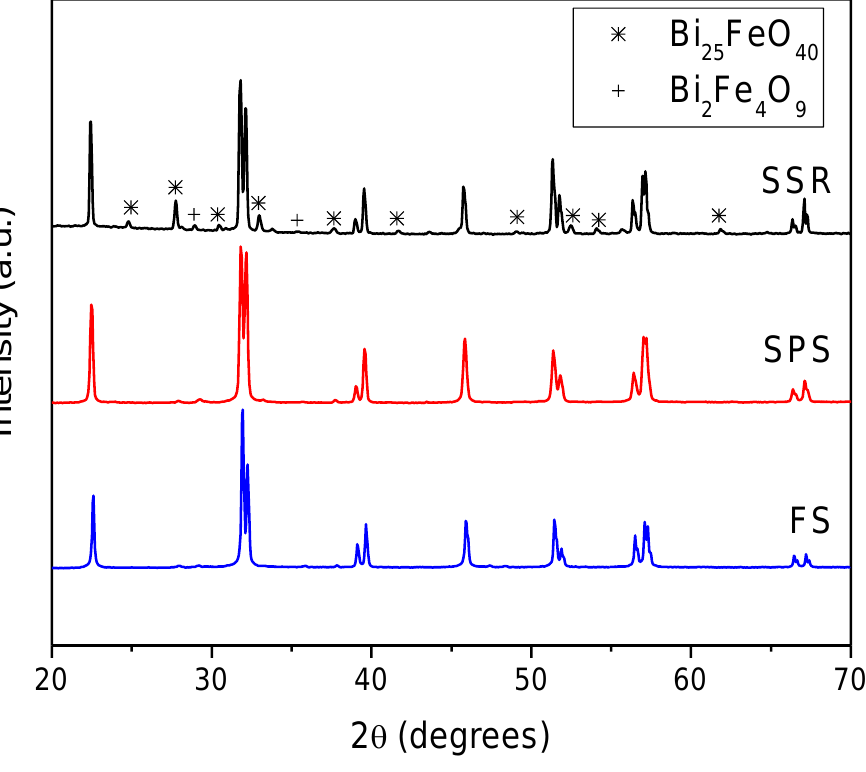
Figure 1. XRD patterns, taken at room temperature, of the BiFeO 3 specimens prepared by the solid-state reaction method (SSR) and by mechanosynthesis and subsequently densified by SPS and